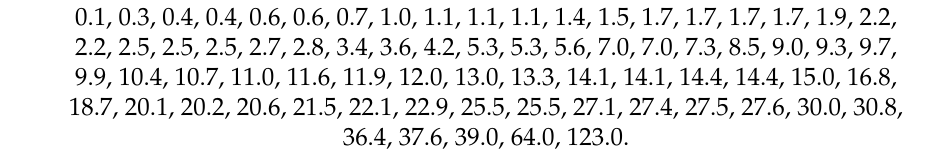
Table 4. The flood peaks data set with summary values.